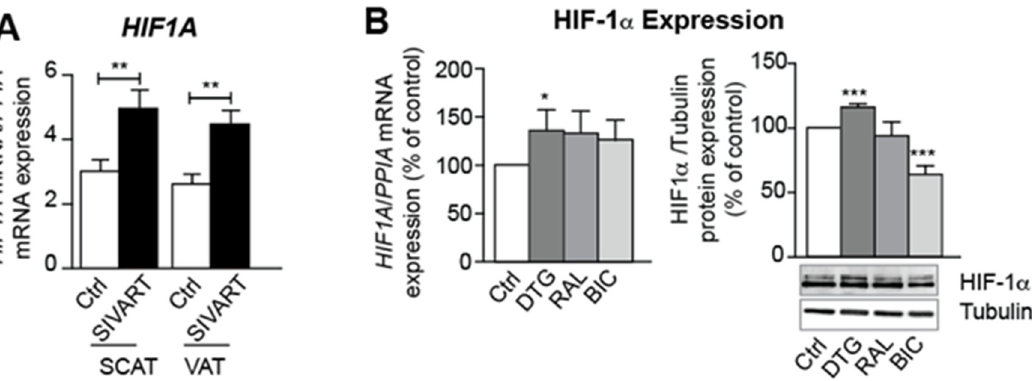
Figure 6. Elevated levels of HIF1A expression are observed in SCAT and VAT from INSTI-treated, SIV-infected macaques and in adipocytes derived from INSTI-treated, beige-differentiated ASCs. Relative mRNA expression levels of hypoxia-inducible-factor-1-alpha ( HIF1A ) normalized against that of PPIA in ( A ) SCAT and VAT from SIVART or control macaques. PCR experiments performed in duplicates using SCAT and VAT from nine control and eleven SIVART macaques. The results are expressed as the mean ± SEM. ASCs were differentiated into adipocytes, as described in Figure 2. ( B ) Relative mRNA expression HIF1A was normalized against that of PPIA . The results are expressed as the mean ± SEM % of control cells ( n = 9, in duplicate) (left panel). Whole-cell lysates were prepared and analyzed using immunoblots. Representative immunoblots of HIF-1 α and tubulin are shown. Densitometry analyses against tubulin as loading control were performed and expressed as a mean % of the value for control cells ± SEM ( n = 6) (right panel).* p < 0.05, ** p < 0.01, *** p < 0.001 vs. control animals or vs. control cells. Table 1. Correlations (Pearson’s test) between HIF1A and beiging-, fibrosis- and lipid-related mark- ers in vivo. Correlation between HIF1A gene expression and beiging-, fibrosis-, and lipid-related gene expression in SCAT and VAT from SIVART and control macaques. Correlations were deter- mined using PCR data obtained using SCAT and VAT from six control uninfected and untreated macaques (Ctrl) and eight SIV-infected and ART-treated macaques (SIVART).